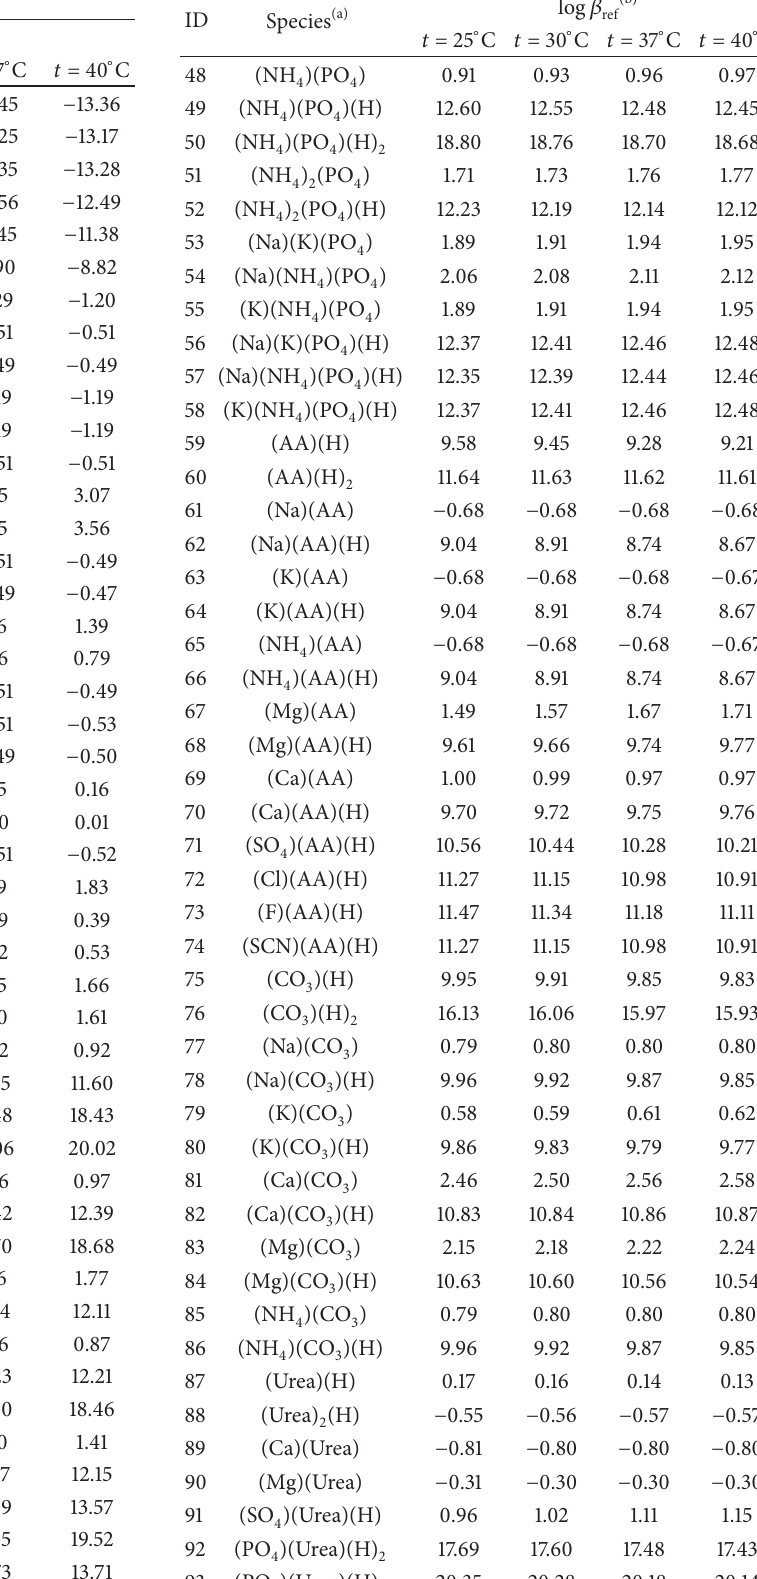
Table 4: Stability constants of SALMO species at 𝑡 = 25, 30, 37, and ionic strength (by 40 ∘ C and 𝐼 ref